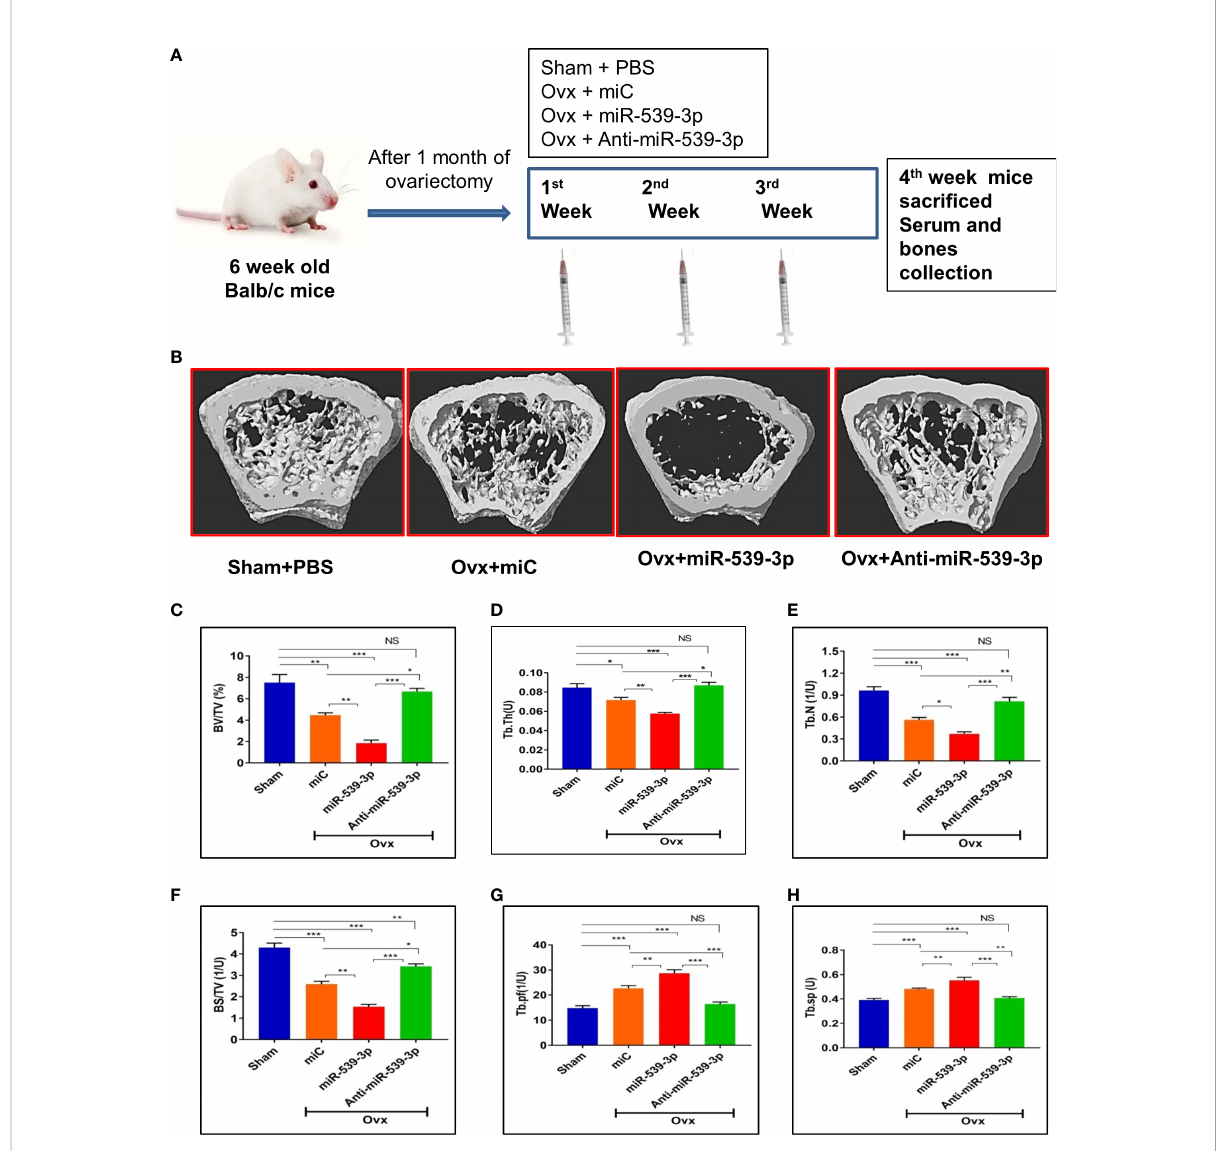
FIGURE 6 miR-539-3p suppresses trabecular bone formation. (A) Work plan of in vivo study. (B) Representative 3d microCT images of femur bone. (C – H) Quanti fi cation of microCT data revealed that anti-miR-539-3p treated mice showed notably enhanced bone parameters, including BV/TV, Tb. N, Tb.Th and BS/TV with a concurrent decrease in Tb.pf and Tb.Sp in femora, while in comparison to the miC group, these variables were reversed in miR-539-3p treated mice. All data represent mean ± SE (n = 6). *p < 0.05, **p < 0.01, ***p < 0.001 and NS, non-signi fi cant compared in between the